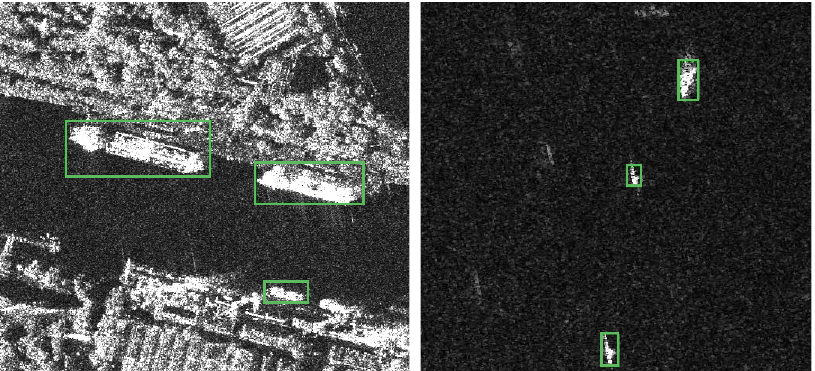
Figure 1. Synthetic Aperture Radar (SAR) ship detection images from the SAR Ship Detection Dataset (SSDD) [5]. Green boxes are ground-truth labels manually